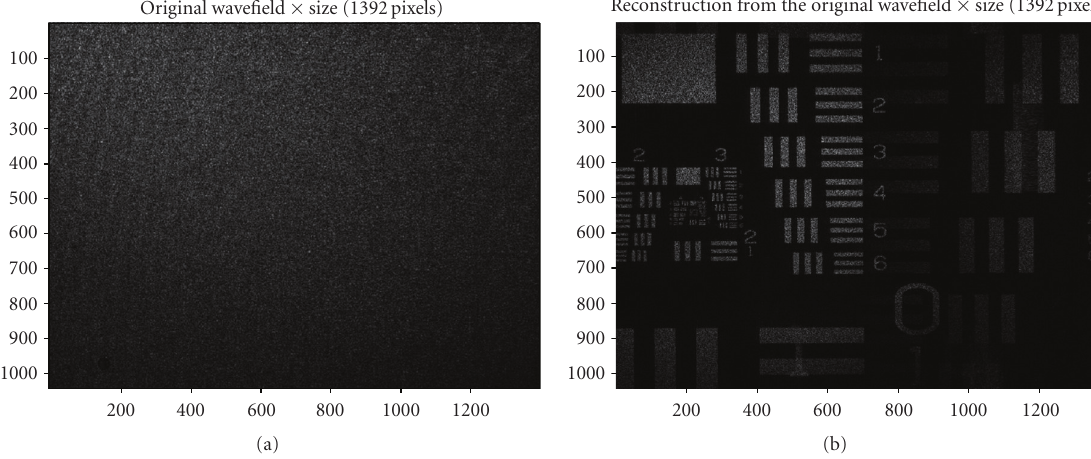
Figure 11: (a) Amplitude of a PSI hologram of a transparent USAF resolution chart having been illuminated through a di ff user. The hologram has 1040 × 1392 pixels. In (b) we show the reconstruction of the digital hologram.